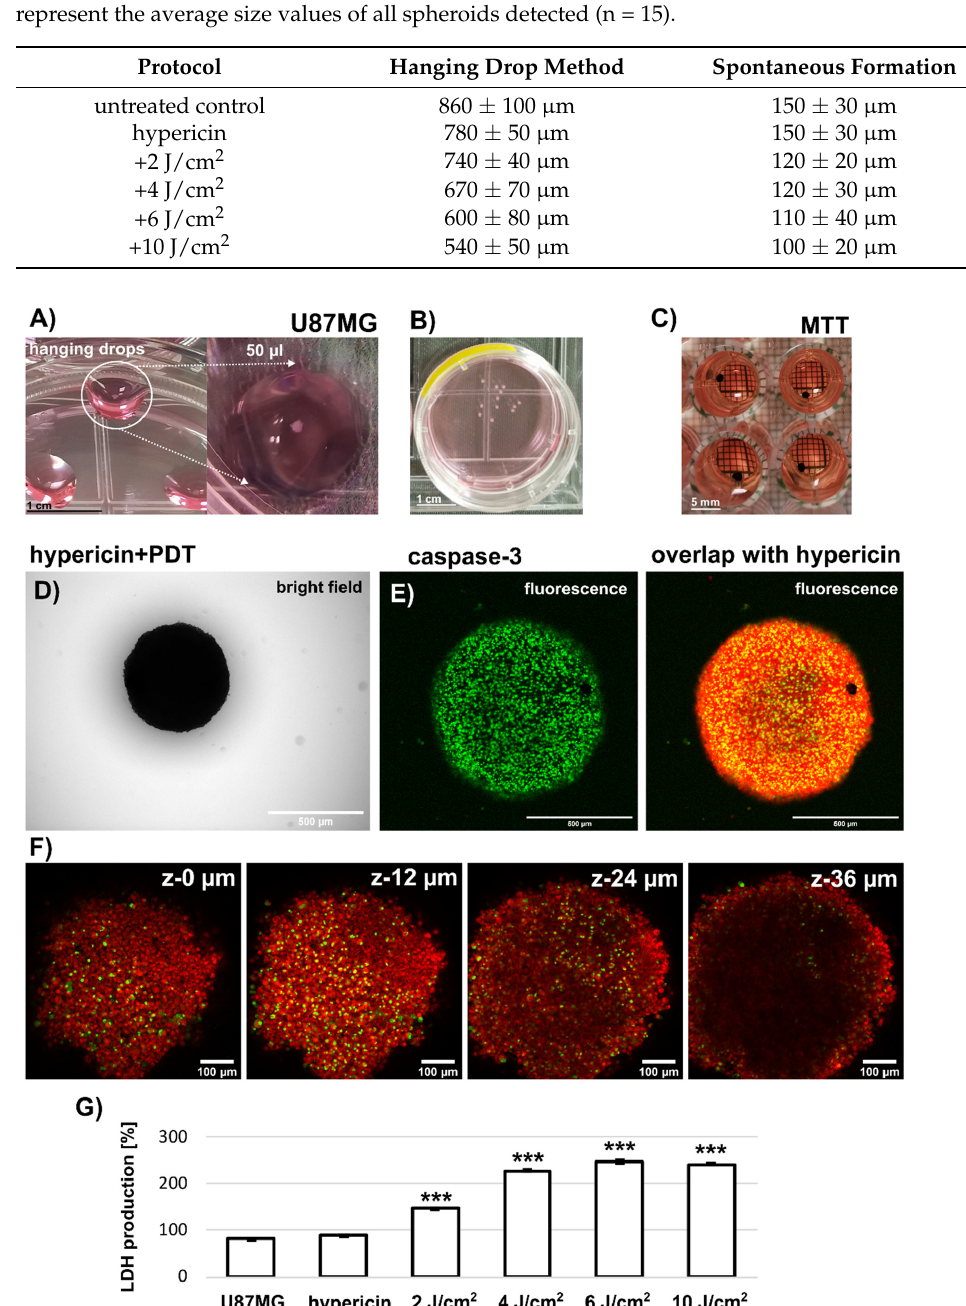
Figure 7. ( A , B ) Representative images of U87MG spheroids grown by the hanging drop method. Scale bar represents 1 cm. ( C ) Representative image of purple formazan formed in the spheroids. Scale bar represents 5 mm. ( D ) Bright field (Scale bar represents 500 µm.) and ( E ) fluorescence images of U87MG spheroids incubated for 3 h with 500 nM hypericin (red fluorescence) and irradiated at 4 J/cm 2 . Caspase-3 (green) was detected 24 h after irradiation. Scale bar represents 500 µ m. ( F ) Z-stack detection of fluorescence in the spheroid. Scale bar represents 100 µ m. ( G ) LDH production in U87MG spheroids without and with 500 nM hypericin and irradiation (2–10 J/cm 2 ). The degree of significant difference was analysed by one-way method ANOVA, *** p < 0.001. The experiments were performed in